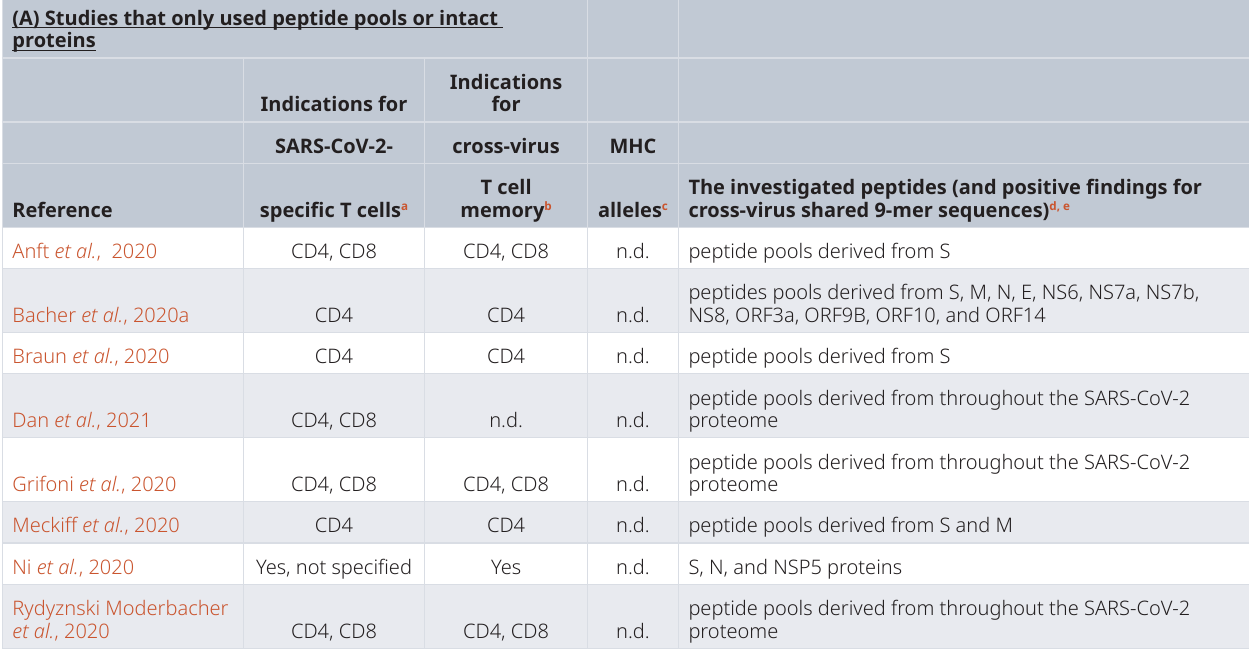
Table 1. Summary of experimental studies on SARS-CoV-2 proteins/peptides in relation to T cell activation. (A) Studies that only used peptide pools or intact